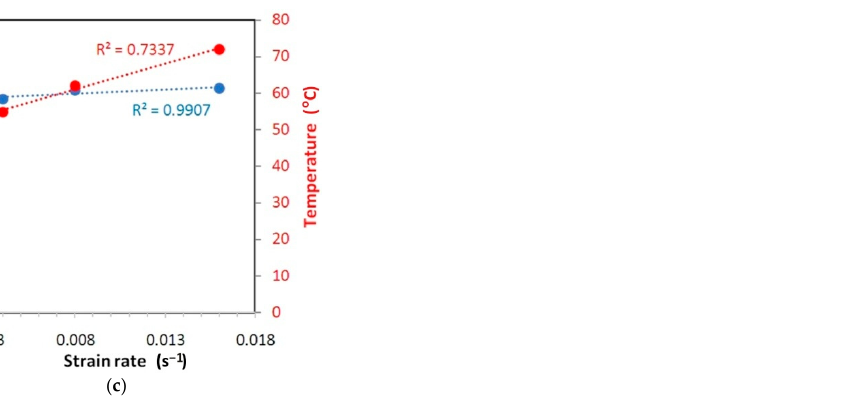
Figure 20. Correlation between the variation of the yield stress and measured temperature for the I625 specimens cut at ( a ) 0° ( ε = 37.2–32.8), ( b ) 45° ( ε = 35.6–39.9) and ( c ) 90° ( ε = 35.8–37).